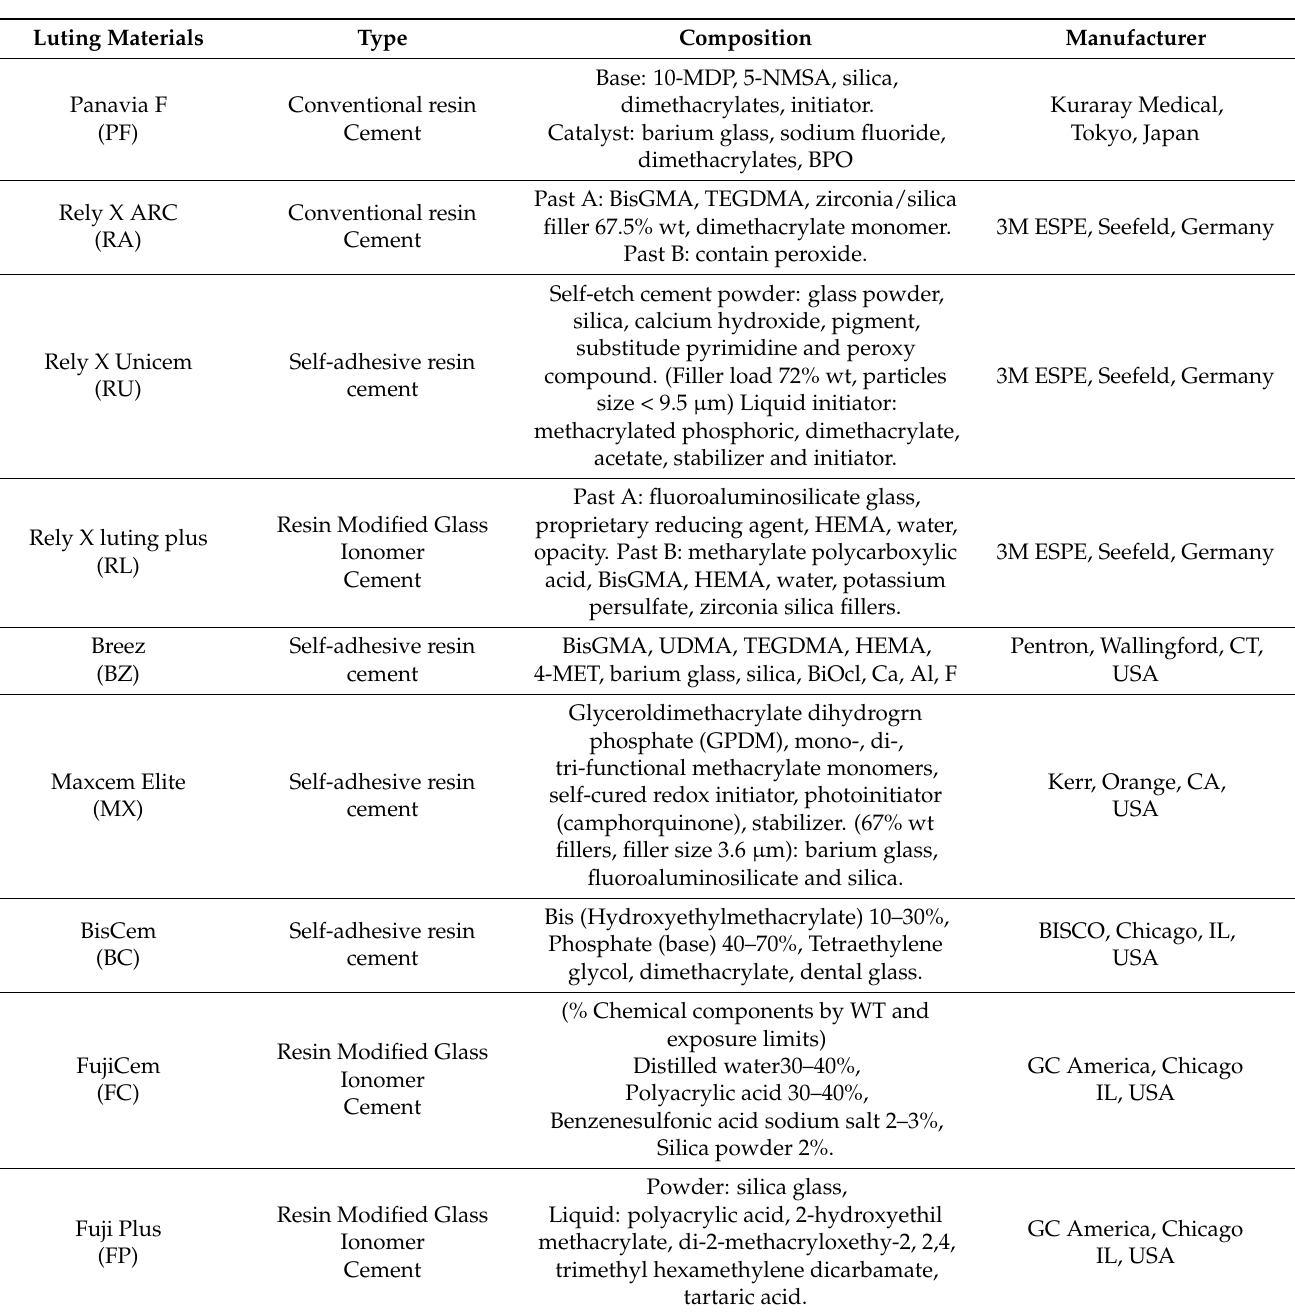
Table 1. List of luting agents assessed in the